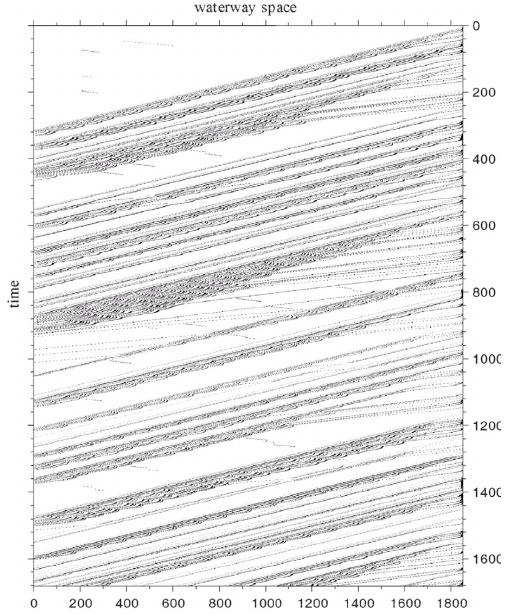
Figure 7. Outbound spatial-temporal spot diagram when prohibit